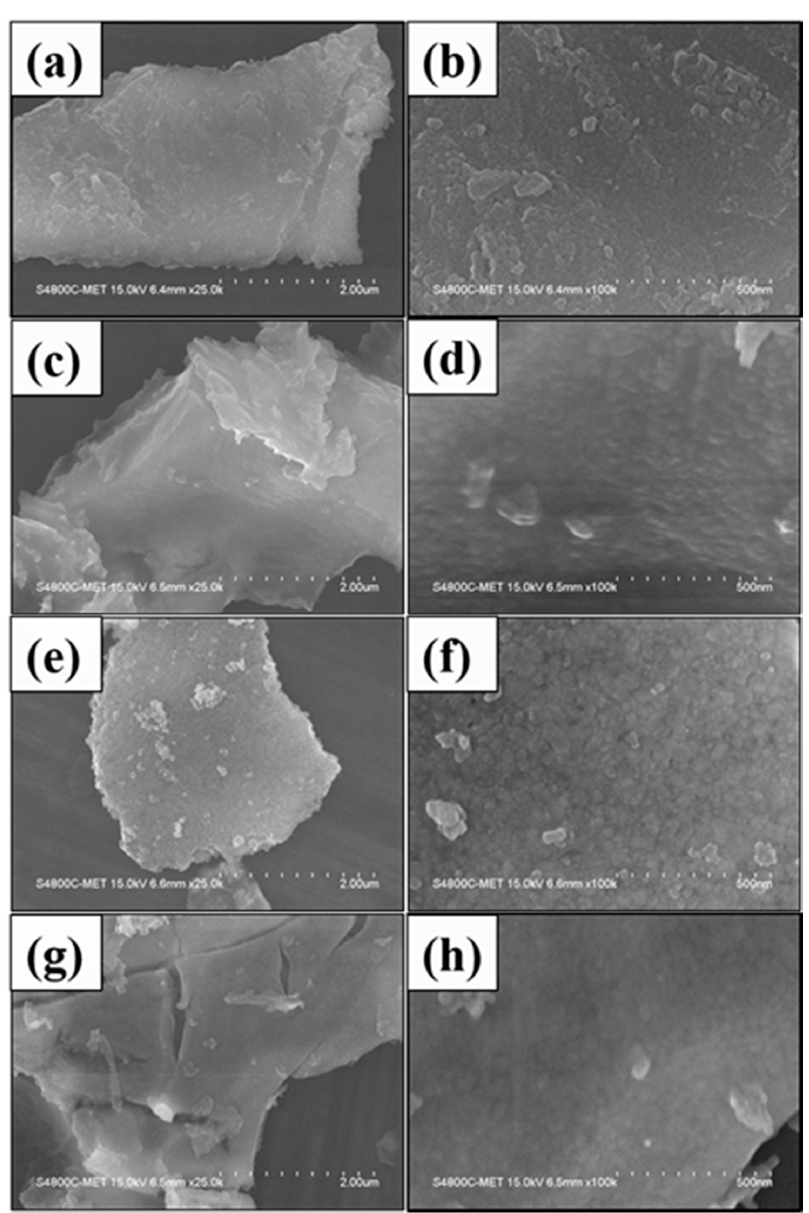
Figure 5. FE-SEM images for pureTiO 2 G-0 ( a,b ), Cu-doped TiO 2 G-1 ( c,d ),G-2( e,f ),andG-3( g,h ).